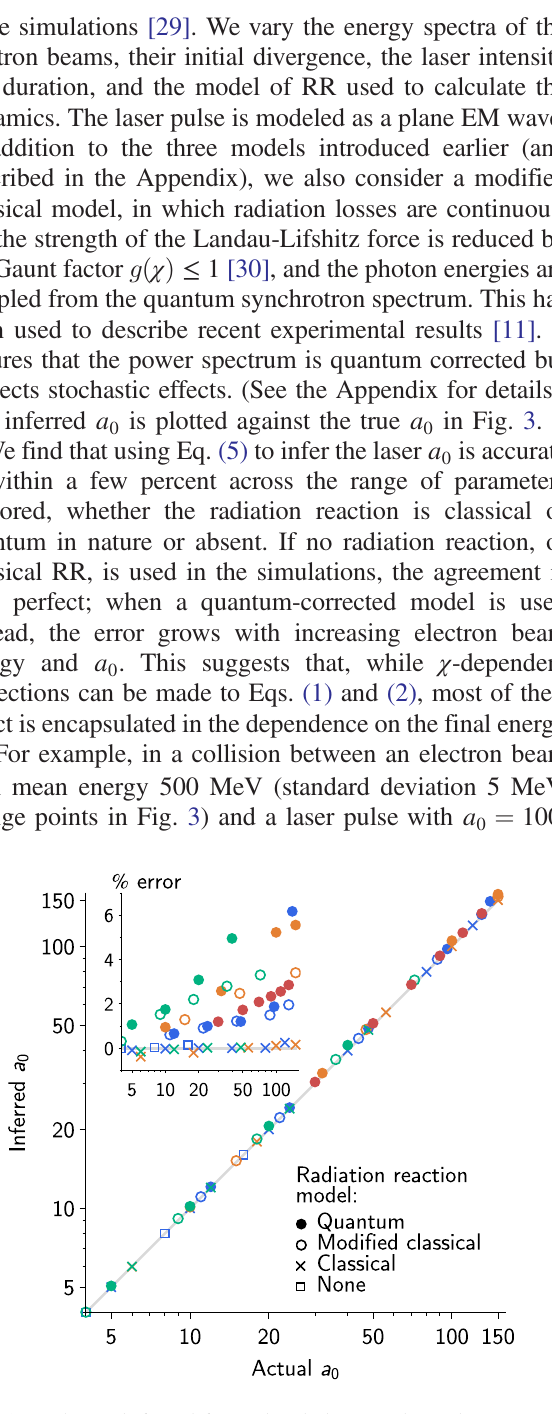
FIG. 3. The a 0 inferred from simulation results, using Eq. (5), and (inset) the percentage error in the same, for a beam of electrons with normally distributed initial energies (mean μ and standard deviation Δ ) and initial divergence δ colliding with a plane-wave laser pulse with normalized amplitude a 0 , wave- length 0 . 8 μ m, and FWHM duration τ : (blue) μ ¼ 250 MeV, Δ ¼ 5 MeV, δ ¼ 1 mrad, and τ ¼ 150 fs; (orange) μ ¼ 500 MeV, Δ ¼ 50 MeV, δ ¼ 3 mrad, and τ ¼ 20 fs; (green) μ ¼ 1000 MeV, Δ ¼ 50 MeV, δ ¼ 2 mrad, and τ ¼ 30 fs; and (red) μ ¼ 200 MeV, Δ ¼ 10 MeV, δ ¼ 2 mrad, and τ ¼ 30